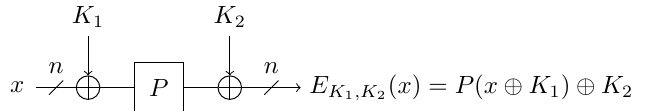
Figure 2: The Even-Mansour construction. P is a public permutation.